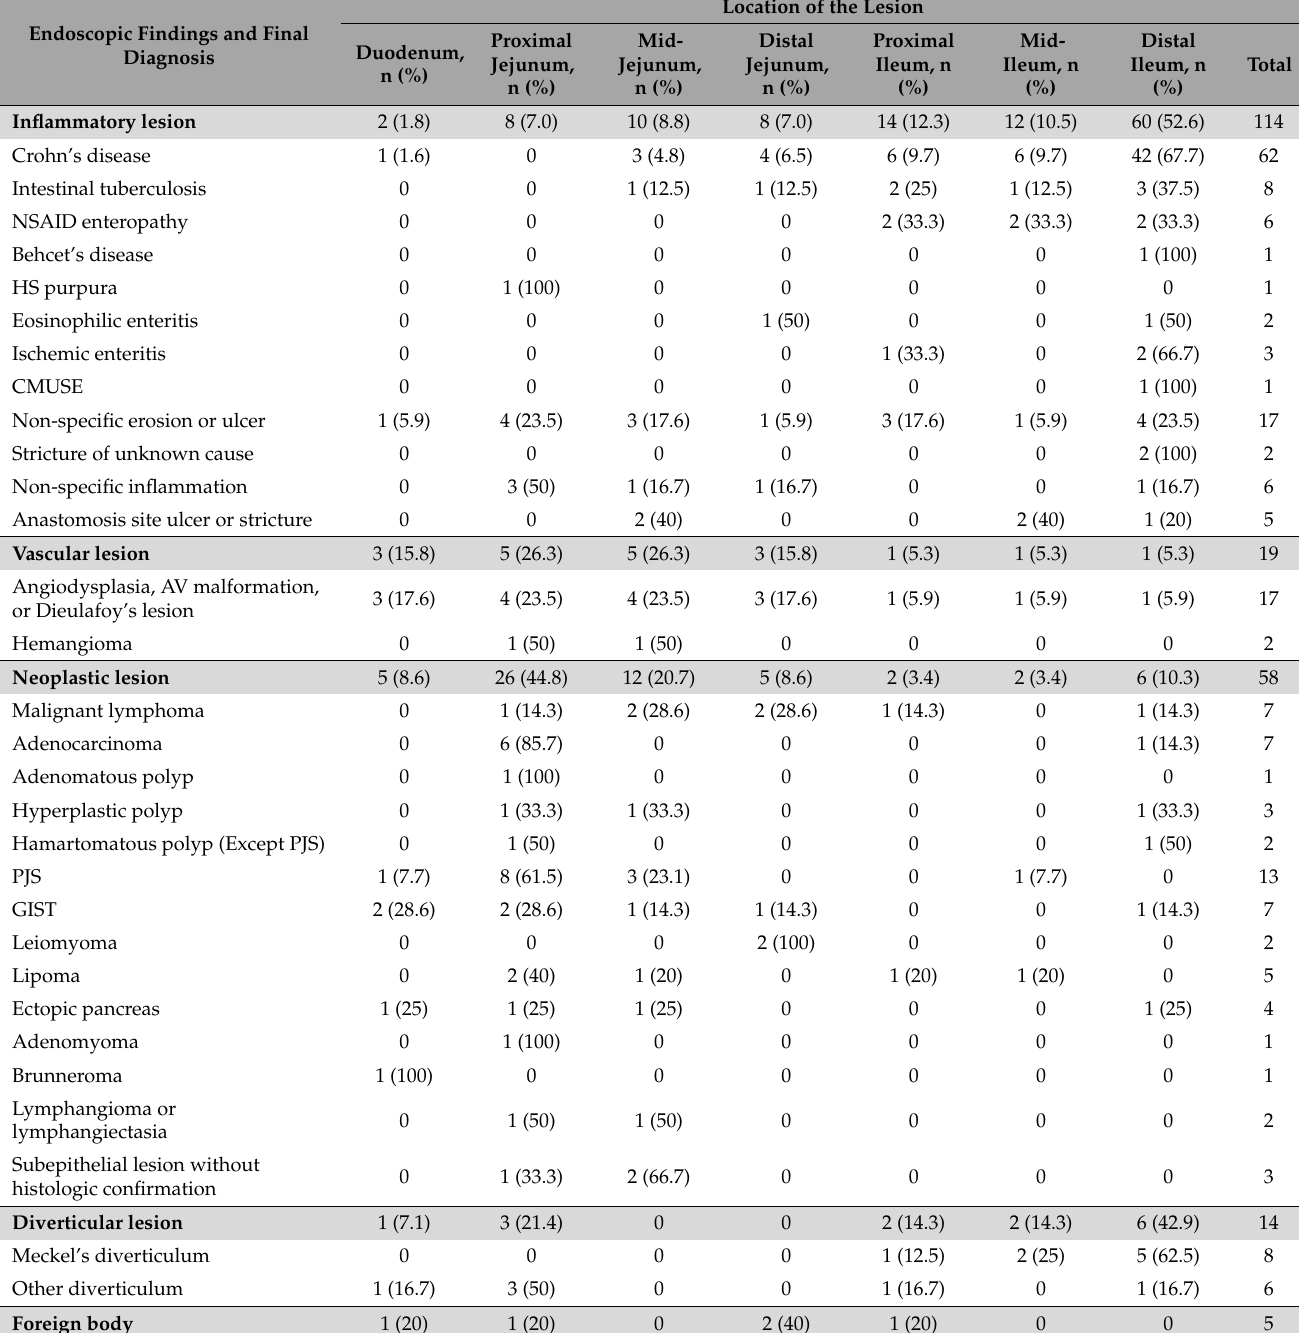
Table 4. Relationship between final diagnosis and location of the